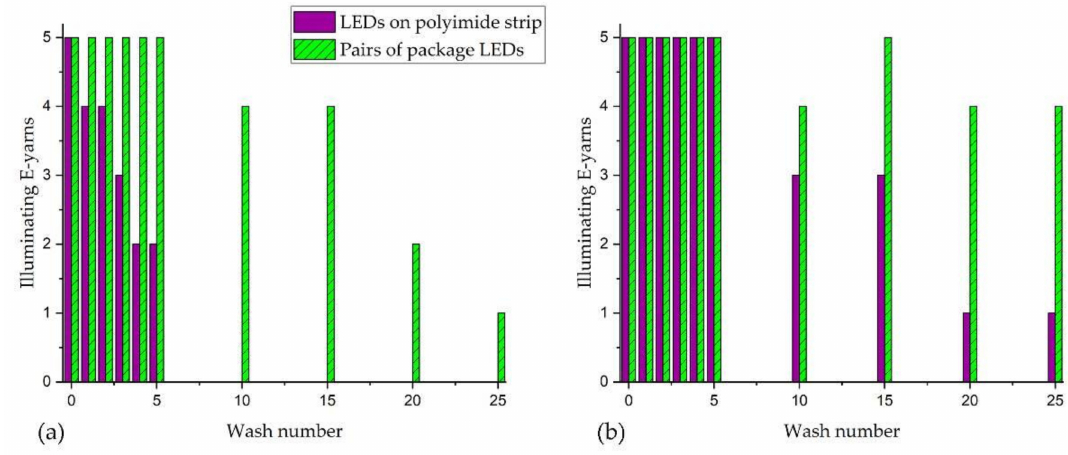
Figure 8. Illuminating E-yarns functioning after washing with: ( a ) tumble-drying; ( b ) line drying.